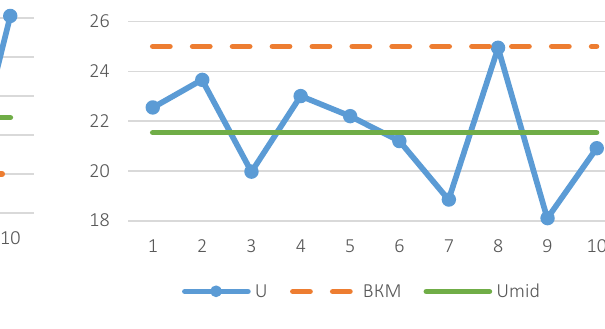
Figure 3. The Shewhart chart for the H4 (instant liquidity) evolution